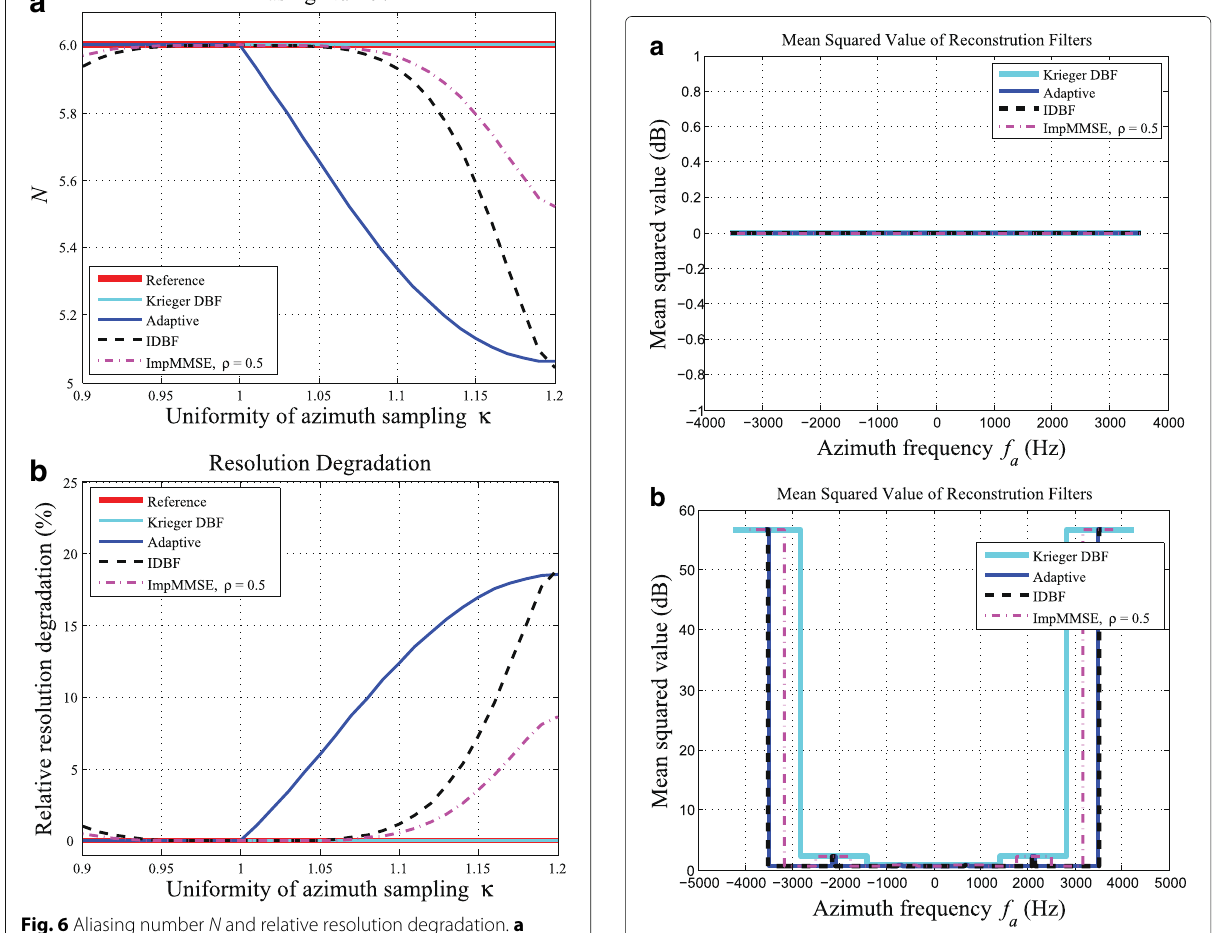
Fig. 7 The mean squared values of reconstruction filters calculated by different reconstruction methods. a The uniform-sampling scheme . b The over-sampling scheme ( κ =